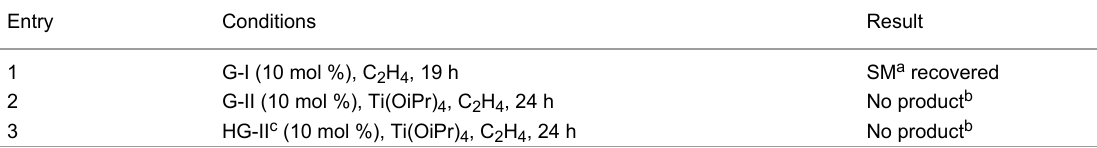
Table 3: Toluene (~0.004 M) reflux conditions to convert 10 to 1a . Entry